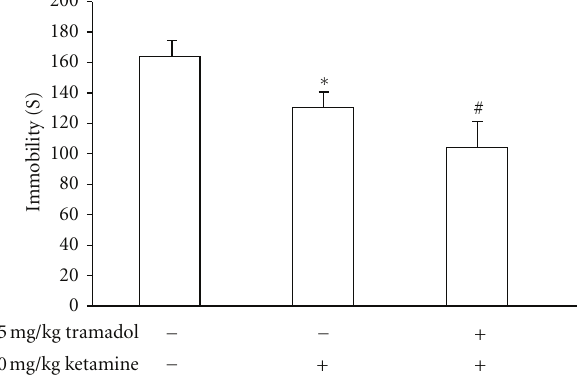
Figure 3: The immobility time of rats ( n = 10) during the FST after intraperitoneal injection of ketamine and pretreatment with tramadol. Ketamine administered at the dose of 10mg/kg significantly decreased the immobility time as compared with control ( ∗ P < 0 . 05), and pretreatment with 5mg/kg tramadol significantly decreased the immobility time as compared with ketamine administration ( # P < 0 .